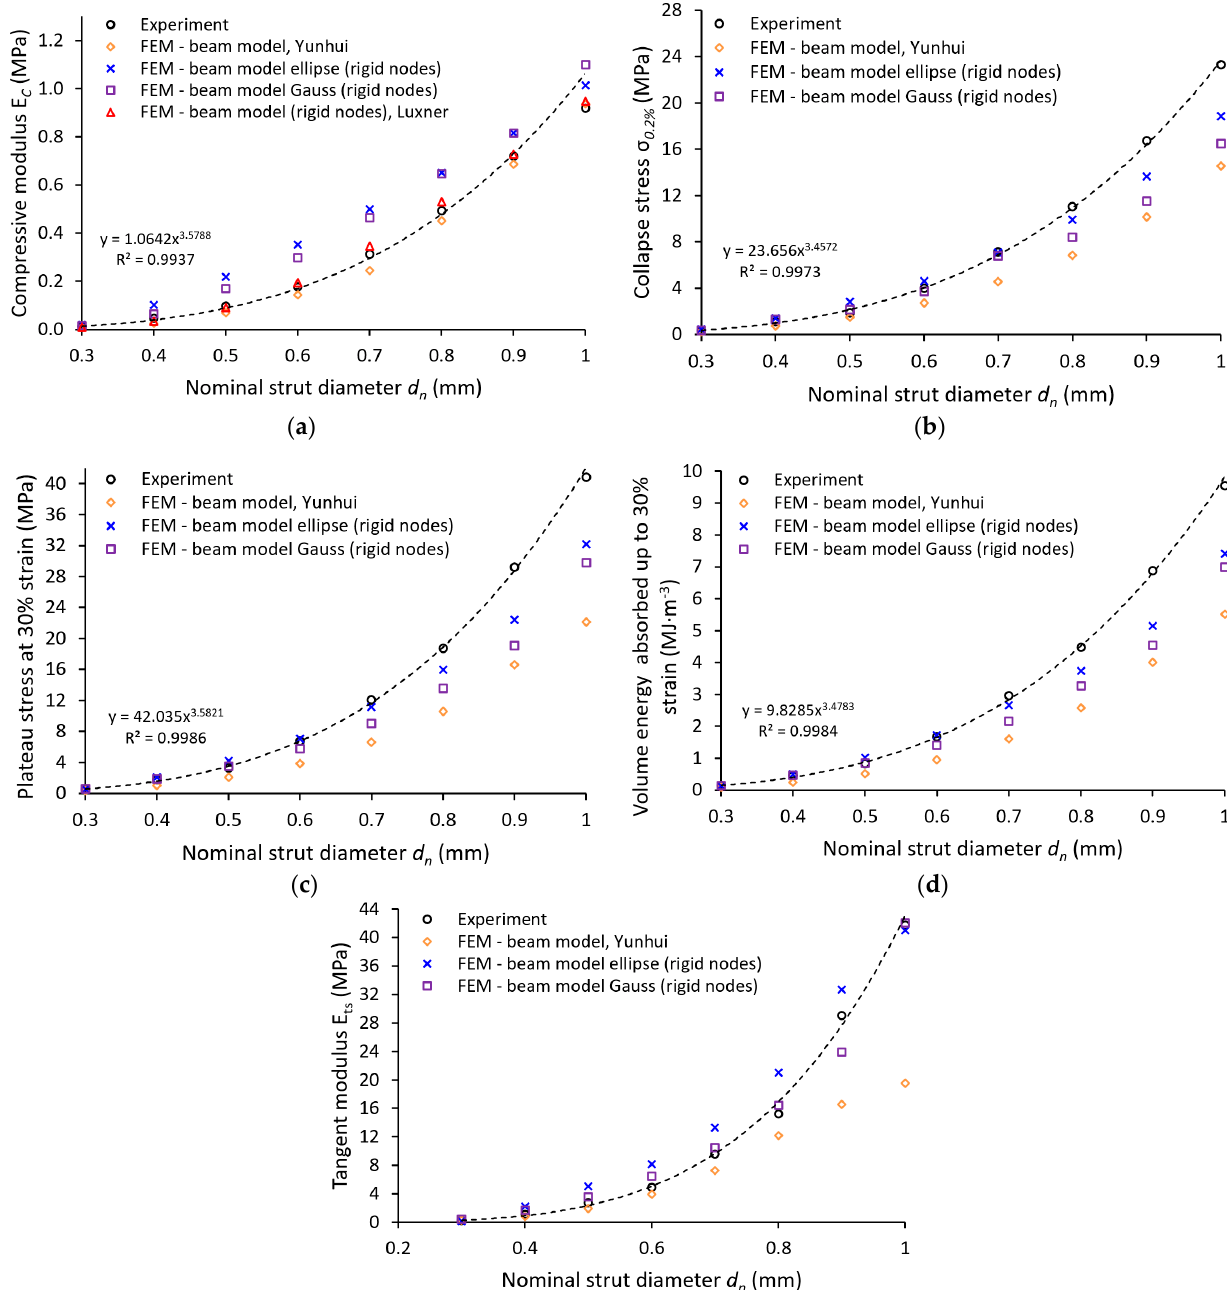
Figure 17. Comparison of quasi-static compression experiment with numerical solutions using different approaches—( a ) compressive modulus; ( b ) collapse stress (0.2% structure strain); ( c ) Plateau stress; ( d ) volume energy absorbed; ( e ) tangent modulus of the structure.